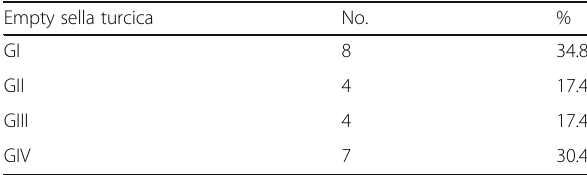
Table 3 Distribution of the studied cases according to